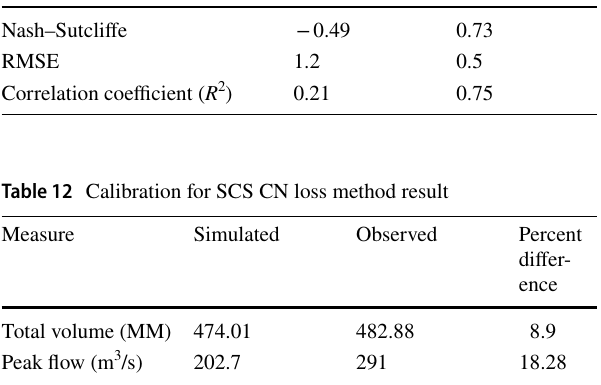
Table 11 Model output with their evaluation criteria Evaluation criteria